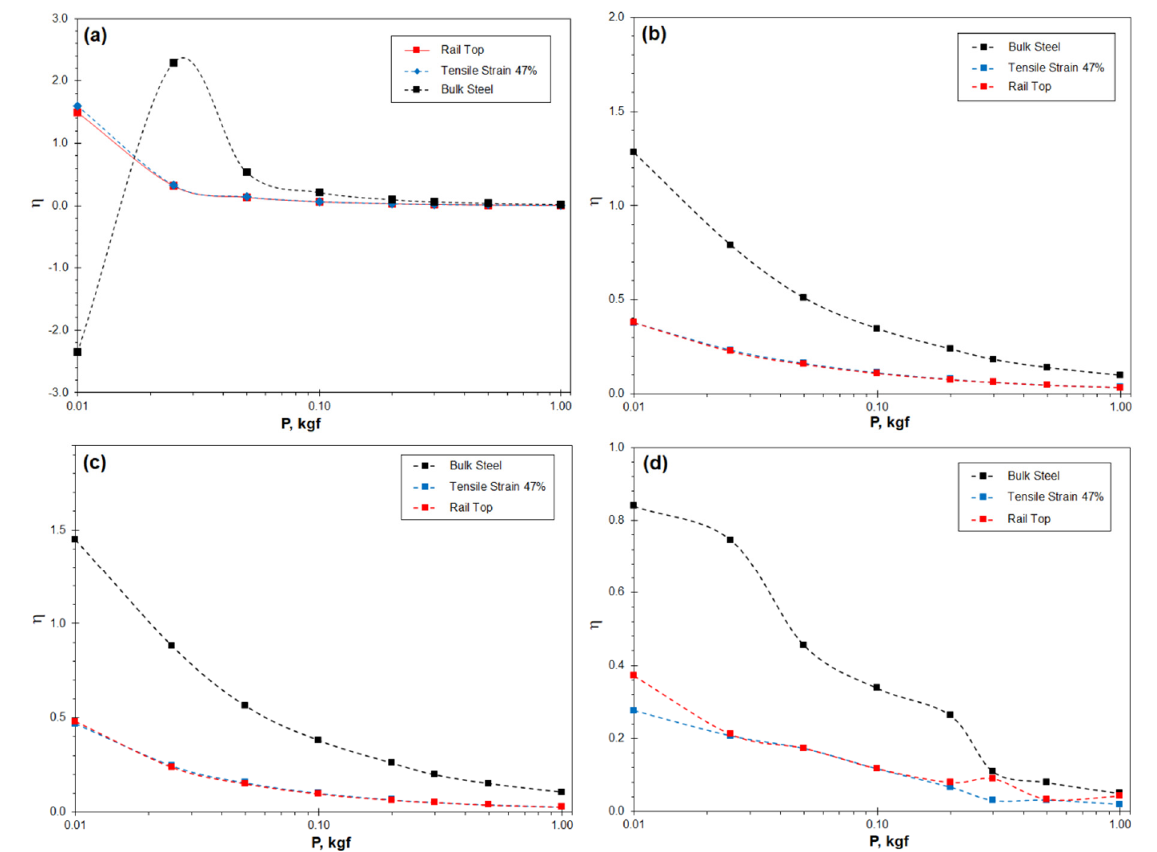
Figure 7. The ISE significance coefficient η of the three Hadfield steel samples determined using the theoretical models: ( a ) using the Hays − Kendall model; ( b ) using the Li − Bradt model; ( c ) using the Li − Bradt model; and ( d ) using the Nix − Gao model.